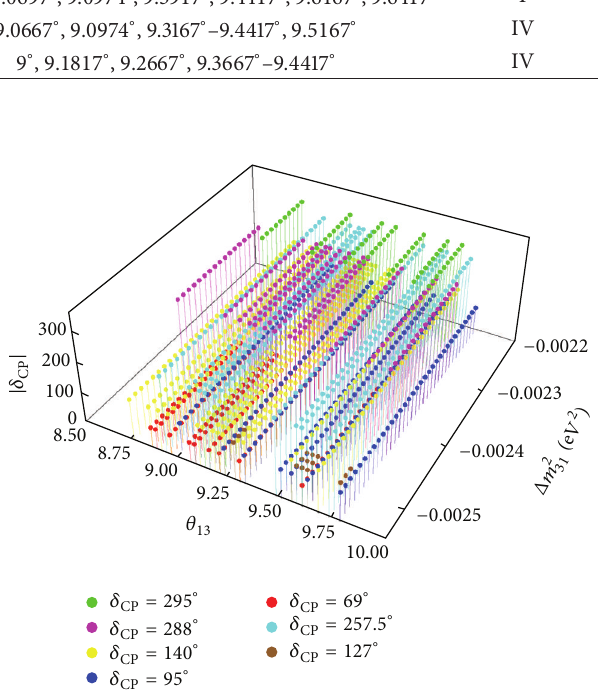
Figure 4: Allowed region constrained by the present BAU bounds, Figure 5: Allowed 3D region constrained by the present BAU < 6.7 × 10 −10 for 𝛿 5.7 × 10 −10 < 𝜂 , 𝜃 13 , and Δ𝑚 2 31 for the case 𝐵 CP , 𝜃 13 , and Δ𝑚 2 31 for the bounds, 5.7 × 10 −10 < 𝜂 𝐵 < 6.7 × 10 −10 for 𝛿 and 𝑈 . The regions are when 𝑅 matrix consists of both 𝑉 CP CKM PMNS and 𝑈 . The regions case when 𝑅 matrix consists of both 𝑉 range at ≥ 2 𝜎 over the corresponding 𝜒 2 obtained by varying 𝛿 CKM PMNS CP range at ≥ 2 𝜎 over the corresponding 𝜒 2 are obtained by varying 𝛿 minima distribution from Figure 2 and 𝜃 13 with its experimental CP minima distribution from Figure 2, 𝜃 13 with its experimental values values varied within 3𝜎 and Δ𝑚 2 31 at its 3𝜎 C.L. The results of our varied within 3𝜎 from its central values, and Δ𝑚 2 31 at its 3𝜎 CL. The calculation are presented for IH and LO case. results of our calculation are presented for IH and HO